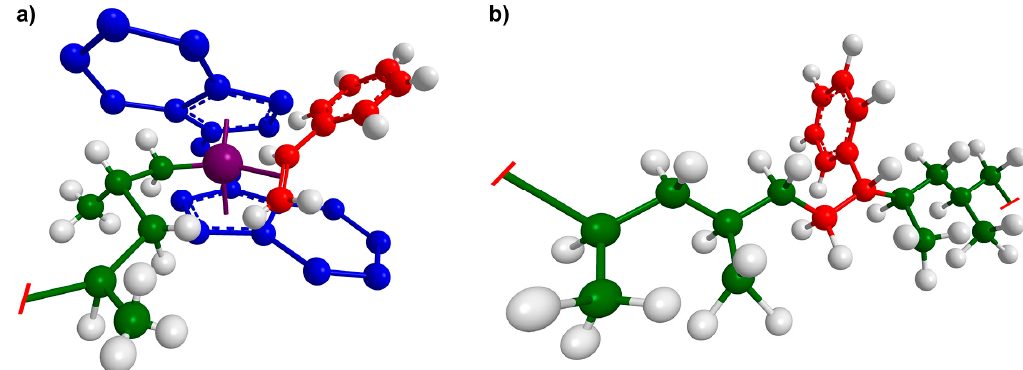
Figure 5. Enantiofacial selectivity of ansa -zirconocene catalyst with C 2 -symmetry for propylene and styrene copolymerization (hydrogen atoms of the complex omitted merely for clarity) ( a ); and the resulting zigzag planar polymer chain ( b ) (propylene and styrene units in the polymer chain are respectively drawn in green and red).